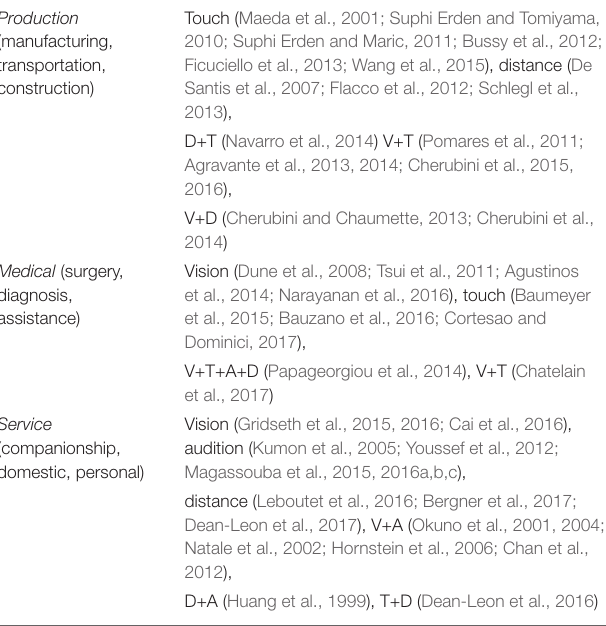
TABLE 4 | Classification based on target/potential sectors. Production (manufacturing,